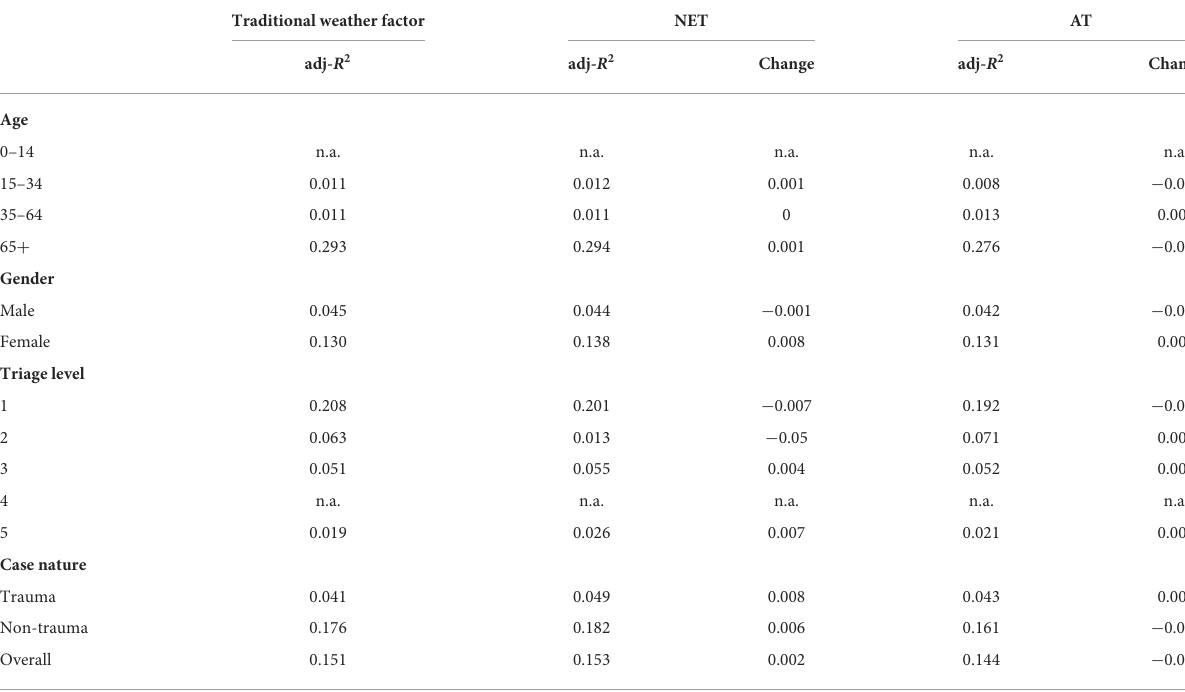
TABLE 2 The difference between using biometeorological indexes and traditional weather factors in describing daily EAS